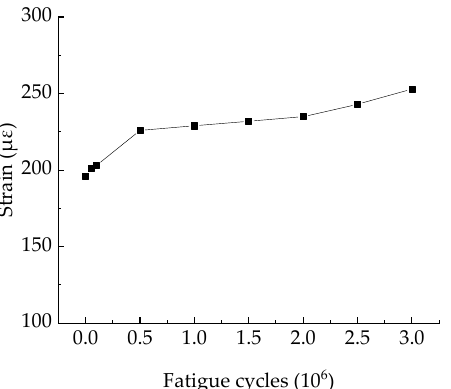
Figure 20. The relationship between the mid-span deflection and fatigue cycles of the reinforced P3.